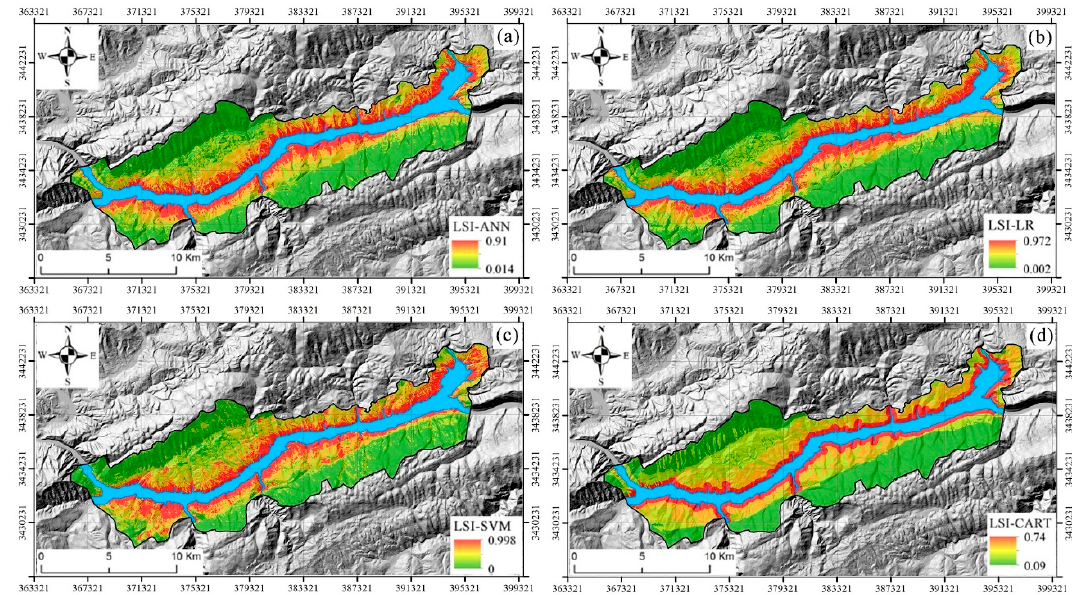
Figure 4. Landslide susceptibility maps obtained from ( a ) ANN model, ( b ) logistic regression (LR) model, ( c ) SVM model, and ( d ) classification and regression tree (CART) model.